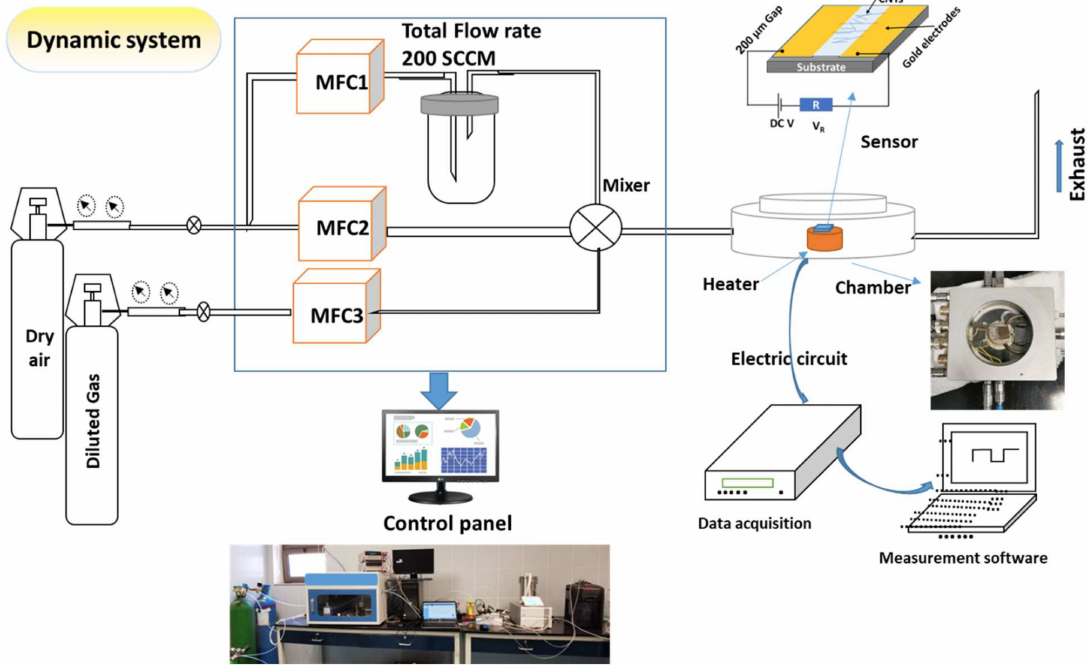
Figure 2. Schematic diagram of the gas sensing